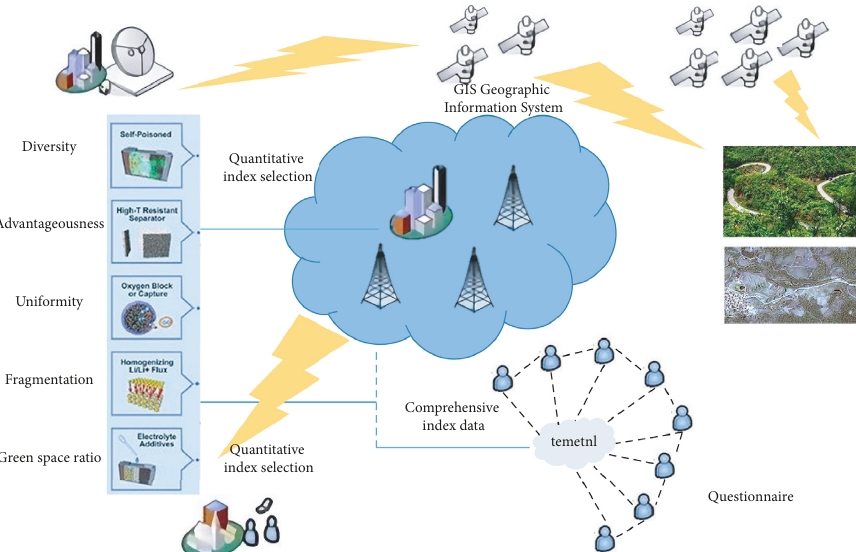
Figure 1: Evaluation process based on highway ecological landscape environment geographic information